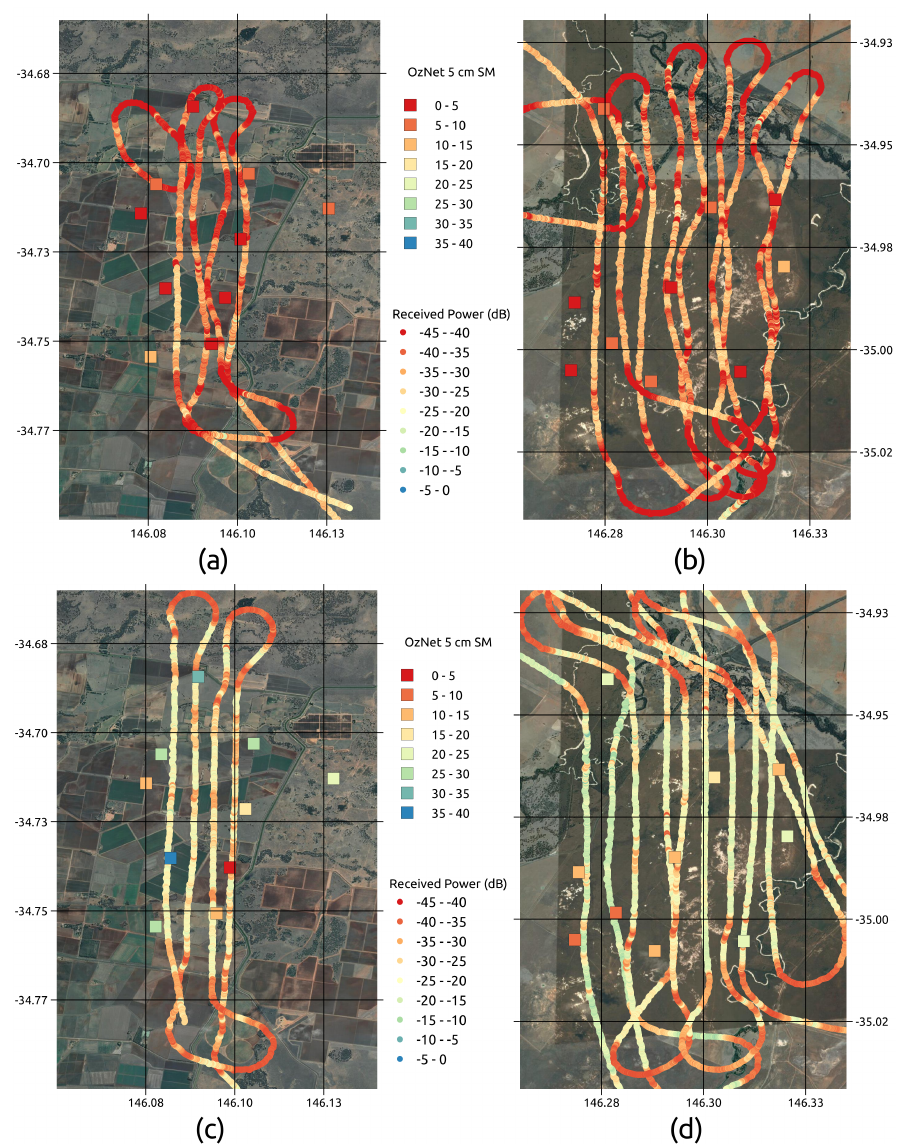
Figure 2. The tracks denoted by the Received Power color scale represent the received power (in arbitrary units) by the Microwave Interferometer Reflectometer (MIR) instrument, and the coloured squares are the in-situ OzNet soil moisture (m 3 /m 3 ) sensors at 5 cm depth. ( a ) Shows the received power and in-situ measurement during Dry flight at ( a ) Site A, and ( b ) Site B; and during Wet flight at ( c ) Site A, and ( d ) Site B. Note: anomalous low reflectivity values for large banking angles during the turns are not used in the